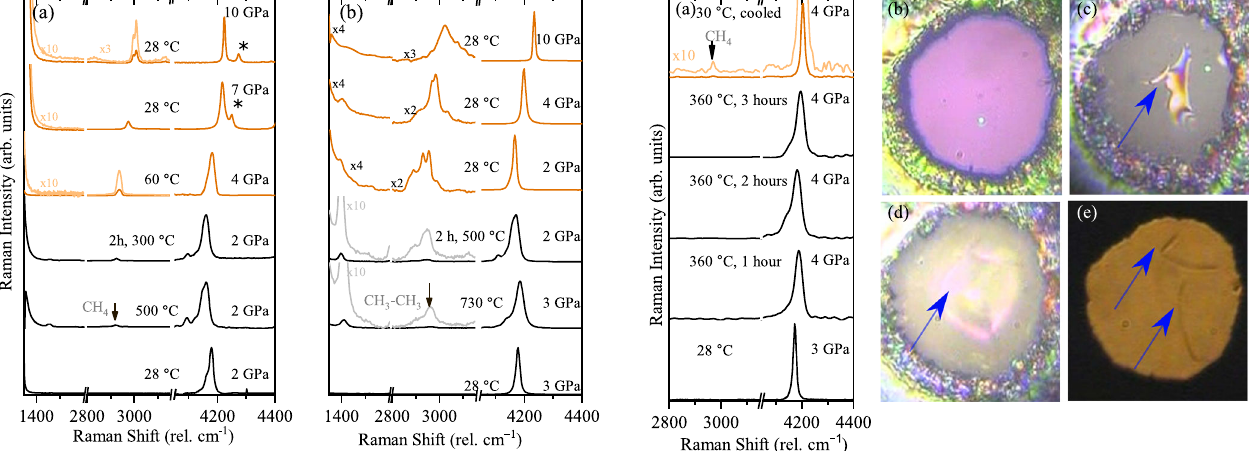
Fig. 3 Hydrogen sample resistively heated during heating and cooling process at 3 GPa, using a diamond anvil cell whose culets and gasket hole had been coated with 300 nm Al 2 O 3 with chemical vapour deposition. a Representative Raman spectra during heating and cooling (orange spectrum). b Image taken in transmitted and re fl ected light, while being heated at 360 °C for 1 h. c Image of the sample at 360 °C for 3 h, the image has been taken in re fl ected light so the region of the chamber where coating is becoming damaged is seen. d Image of the sample after cooling in transmitted light. e Image of the sample after cooling down only in transmitted light. Blue arrows are used to point the regions of the damaged Al 2 O 3 layer; green spots are due to the laser